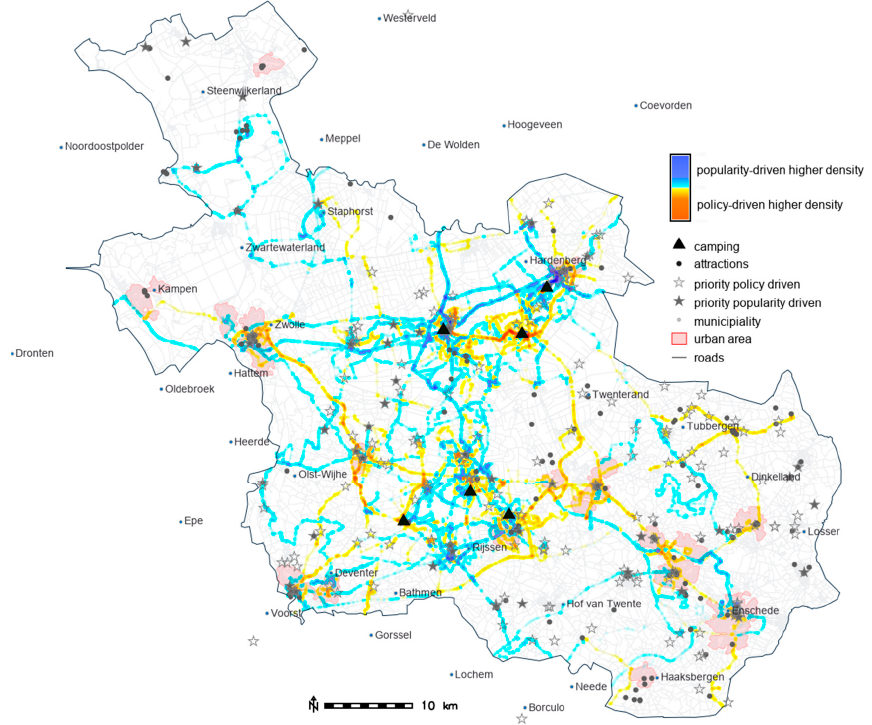
Figure 7. Difference between popularity-driven and policy-driven participants.